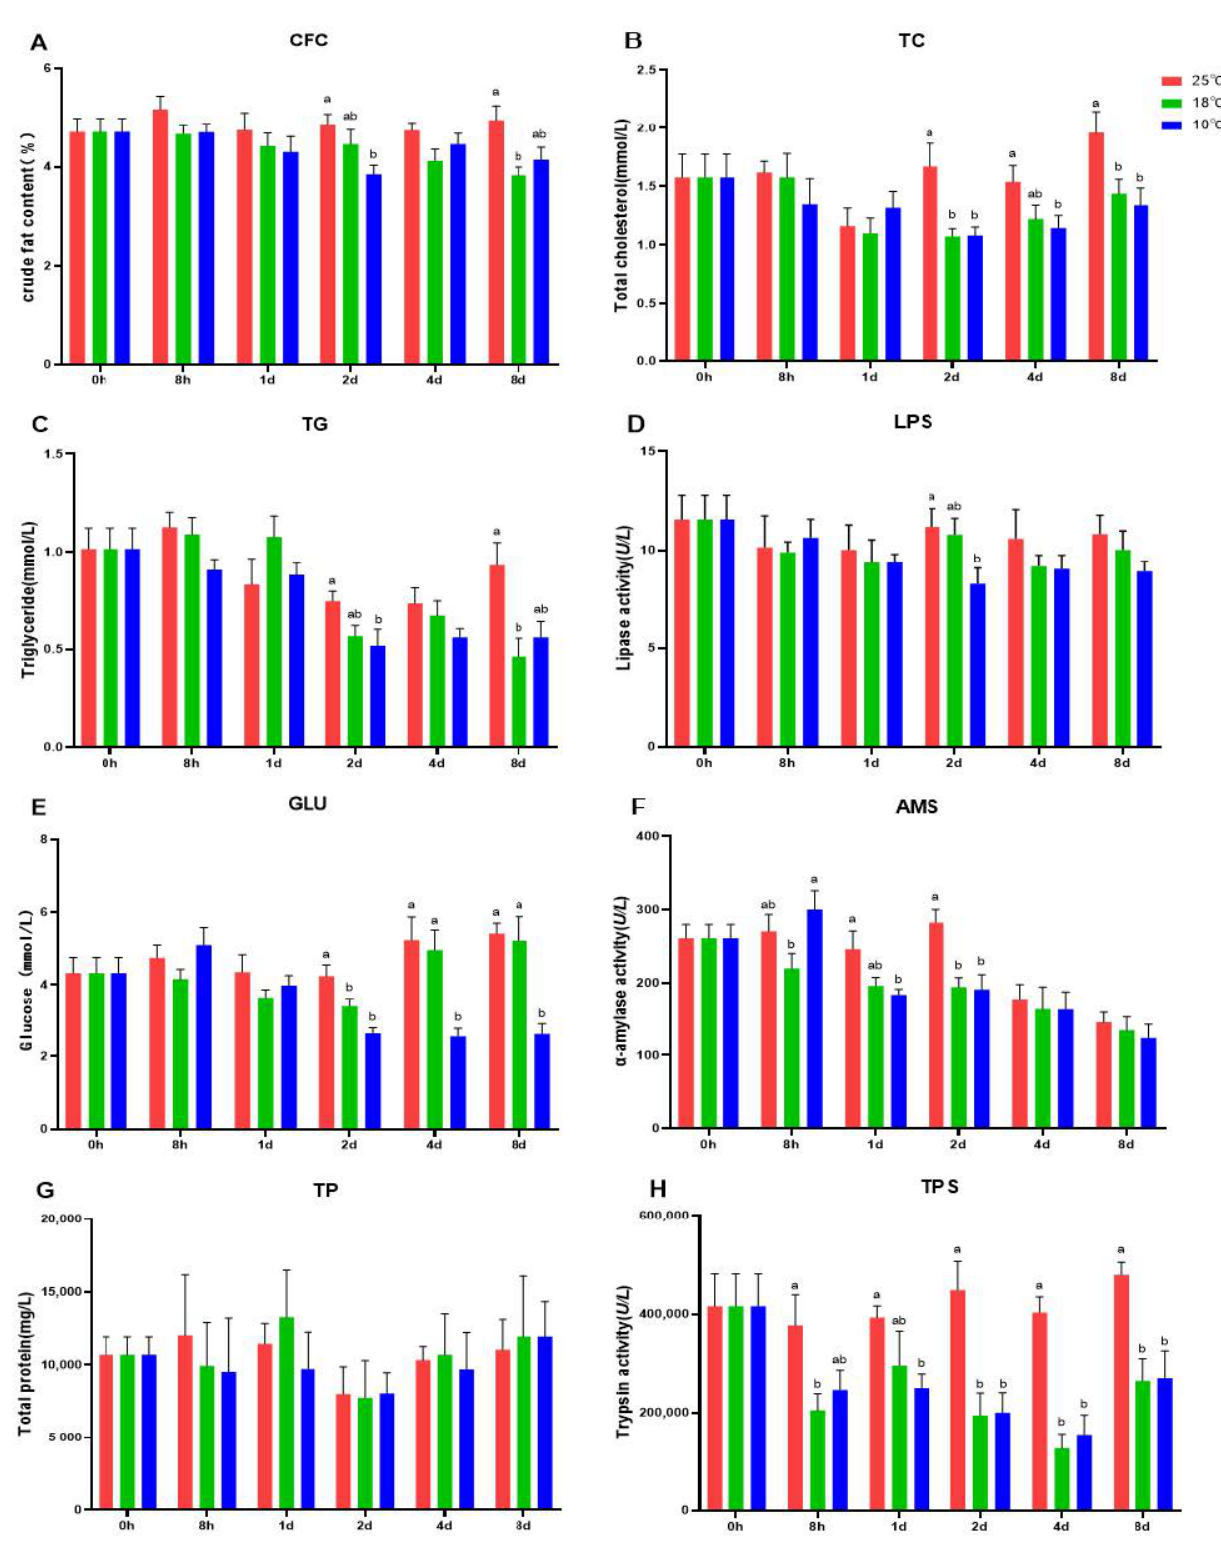
Figure 2. Body composition and plasma biochemical parameters of freshwater drums induced by cold stress ( n = 9): ( A ) crude fat content, CFC; ( B ) total cholesterol, TC; ( C ) total triglyceride, TG; ( D ) lipase activity, LPS; ( E ) Glucose, GLU; ( F ) α -amylase activity, AMS; ( G ) total protein, TP; ( H ) trypsin activity, TPS. The statistical differences are indicated with different superscript letters (a, b) ( p < 0.05).